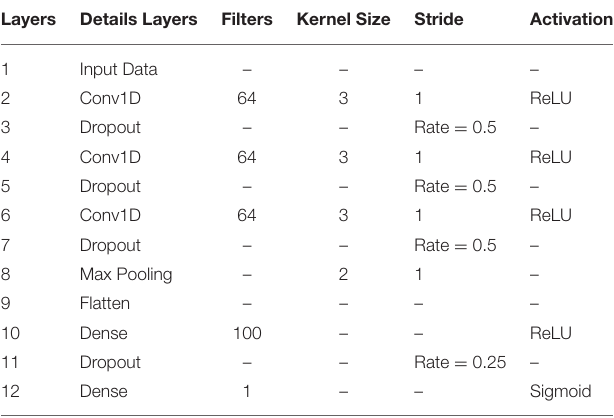
TABLE 2 | The details of the second proposed 1D-CNN model.